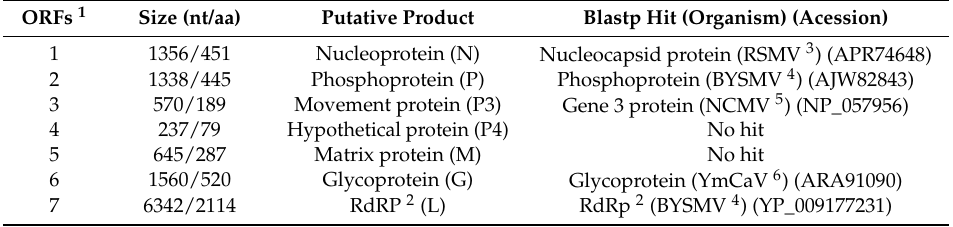
Table 3. Features of the ORFs encoded by bean-associated cytorhabdovirus.